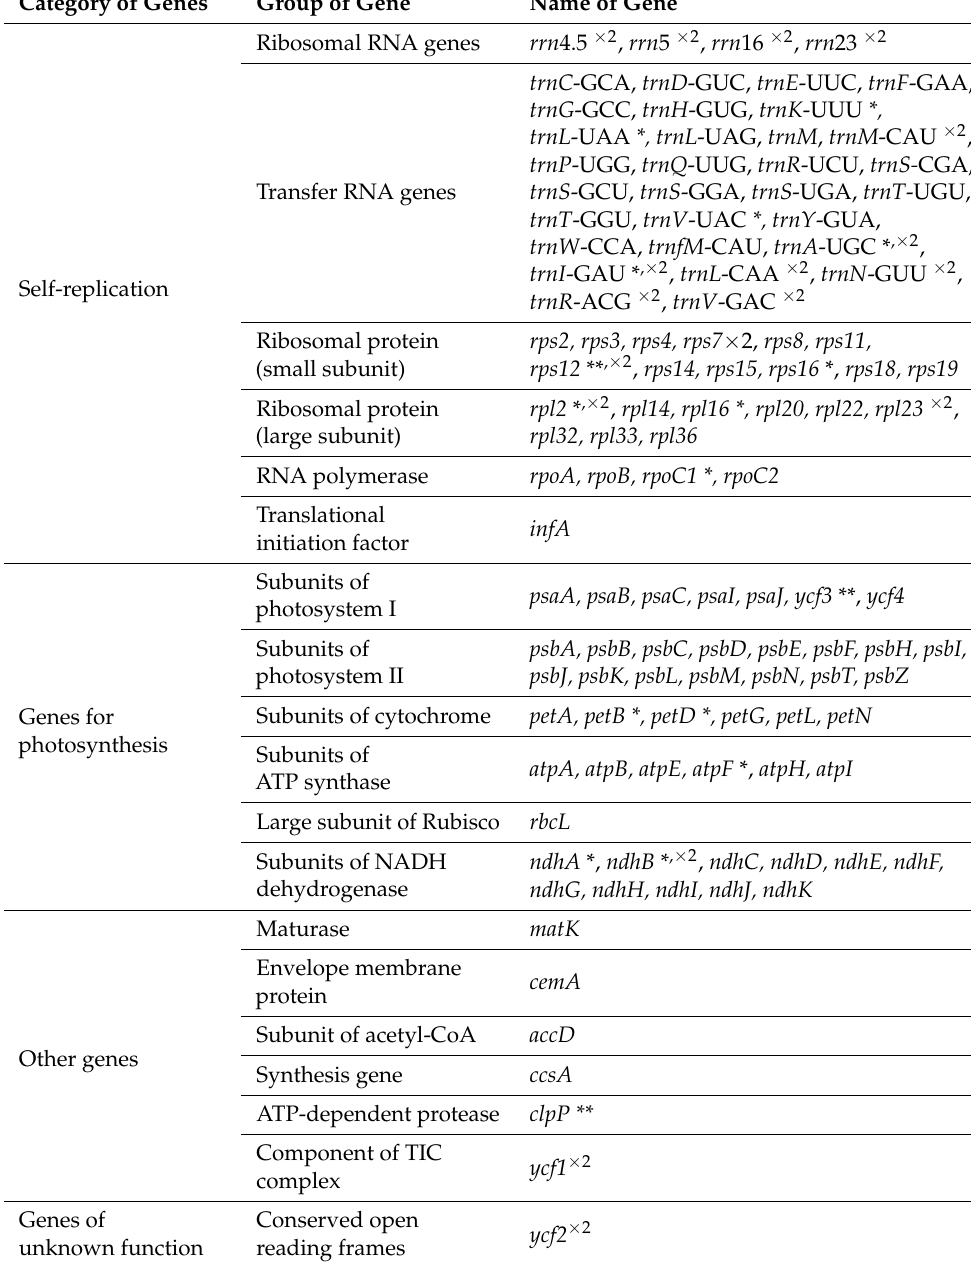
Table 1. List of genes identified in four Anubias